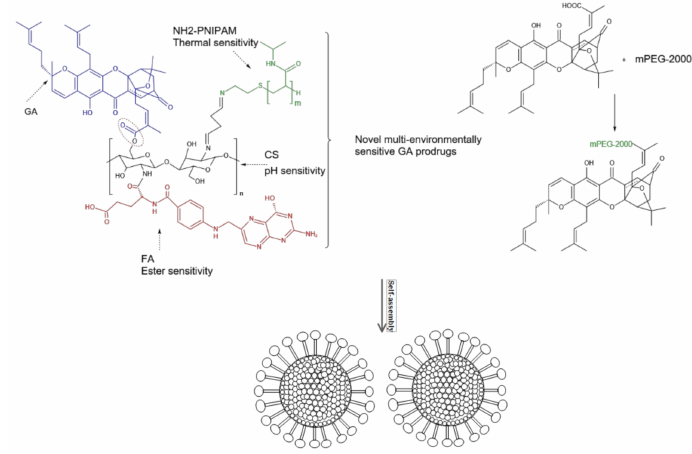
Figure 10. GA prodrug nano